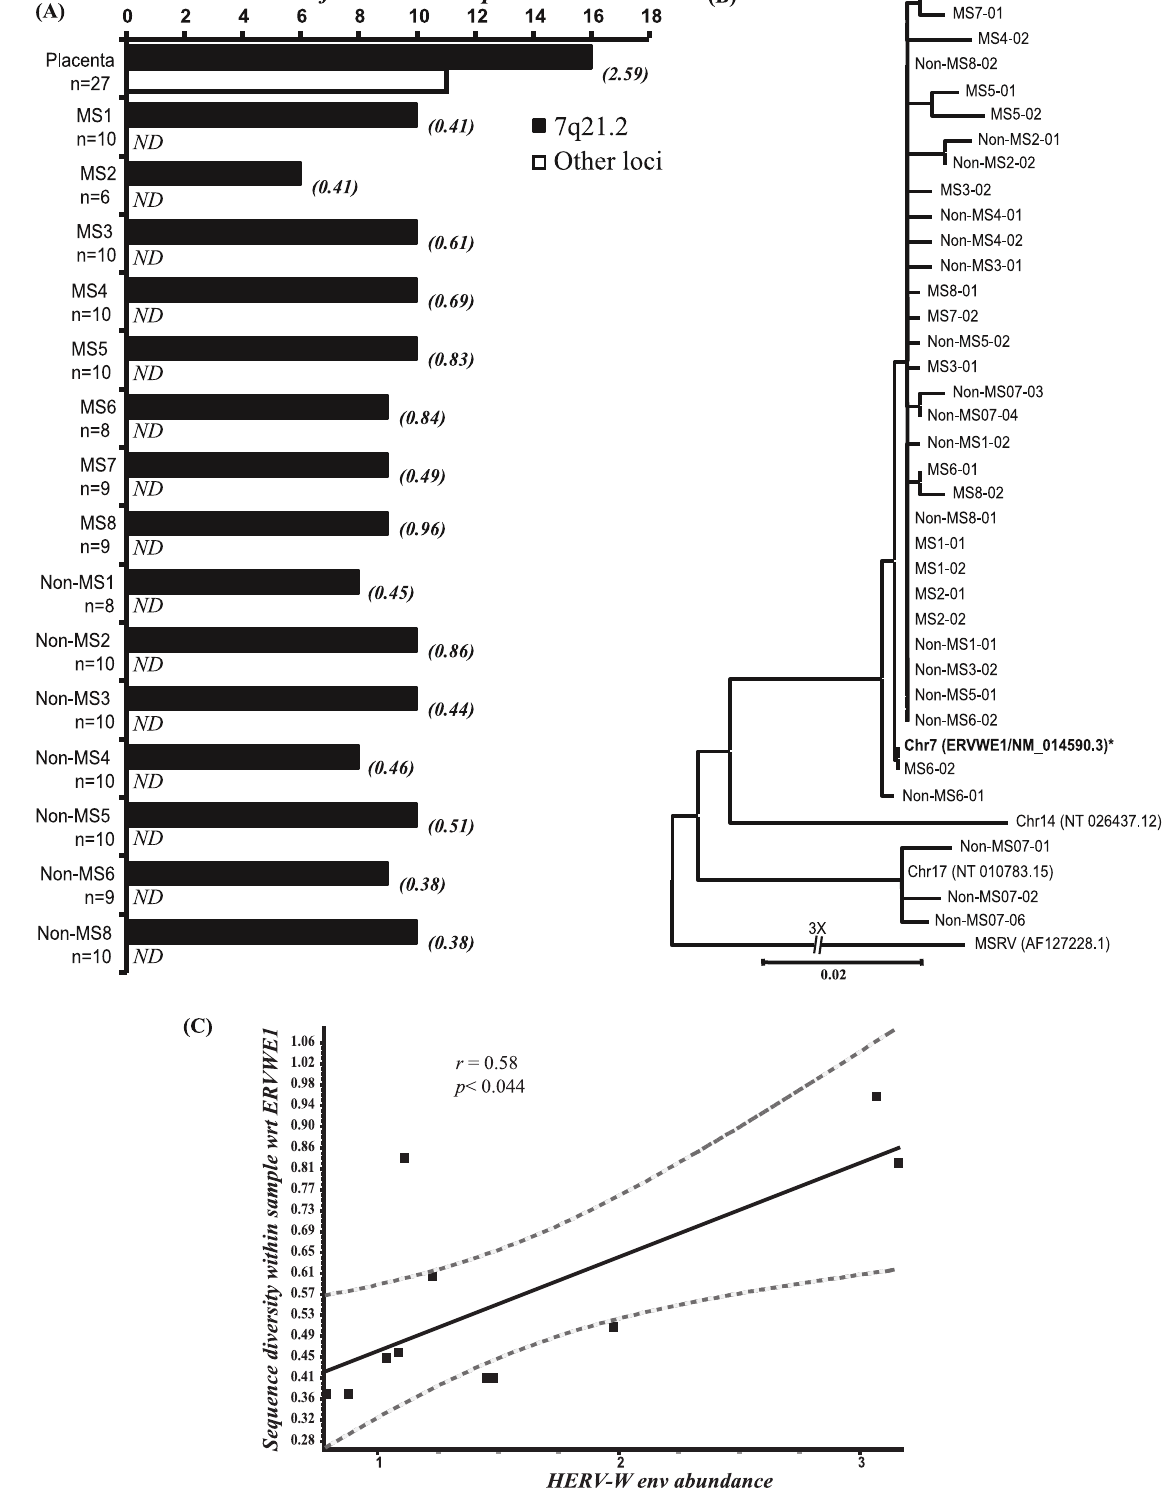
Figure 3. HERV-W env sequence analyses from autopsied brain white matter. ( A ) Chromosomal loci encoding HERV-W env sequences in MS and non-MS samples showed 7q21.2 was the predominant locus in MS and non-MS samples, while placental clones were derived from multiple chromosomal locations. Values in parenthesis indicate percent diversity among clones for each patient relative to ERVWE1. ( B ) Phylogenetic analysis of HERV-W env sequences from MS and non-MS samples, based on DNA sequence by the neighbor-joining method. The tree was rooted to MSRV prototype env sequence, which was used as an out-group gene sequence. ( C ) Correlation between sequence diversity within samples with respect to ERVWE1 and HERV-W env abundance in MS and non-MS samples. (ND=none detected).